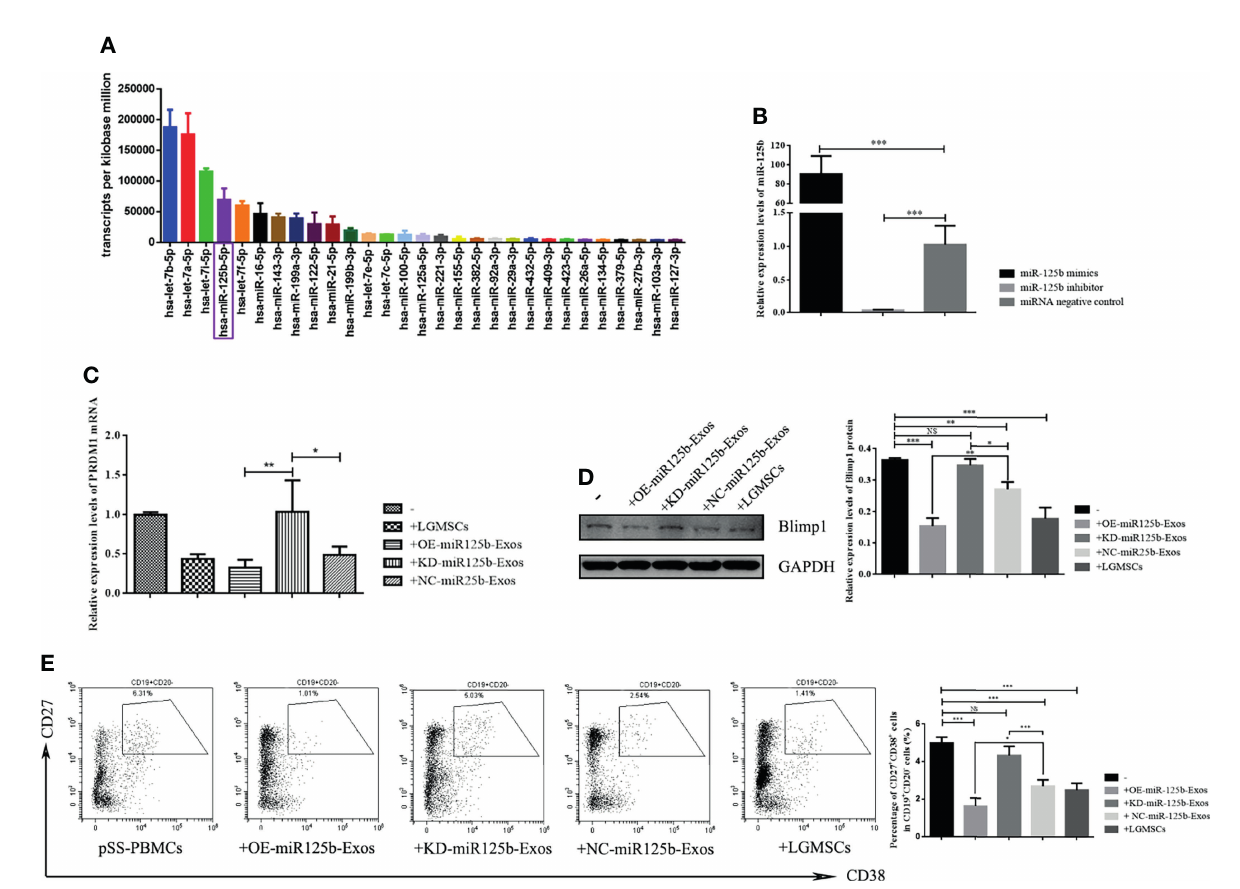
FIGURE 6 | MiR-125b mediates LGMSC-Exos-induced plasma cell alteration and PRDM1 expression. (A) Top thirty most abundant miRNAs in LGMSC-Exos, as assessed by miRNA sequencing. (B) qRT-PCR results of the knockdown and overexpression ef fi ciency after transfection with miR-125b mimics and inhibitors. (C) Relative mRNA expression levels of PRDM1 after coculture with transfected LGMSC-Exos. (D) Western blotting analysis of PRDM1 after cocultured with transfected LGMSC-Exos. (E) Representative fl ow cytometry pro fi les and statistical results of the proportions of CD19 + CD20 - CD27 + CD38 + plasma cells. Data represent the mean ± standard deviation (SD; n = 3 independent experiments). NS, not signi fi cant, ***p < 0.001, **p < 0.01, *p <